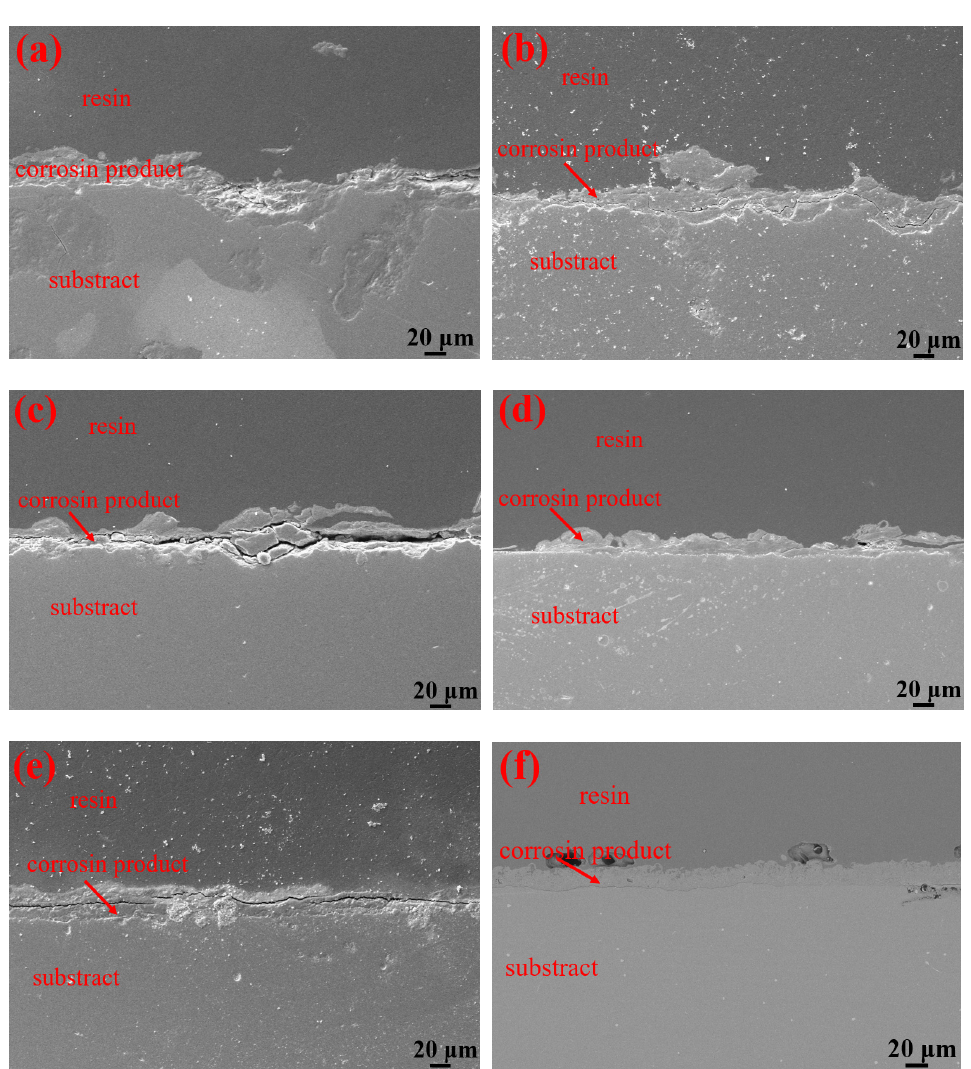
Figure 6. SEM cross-section images of corrosion products of S135 and G105 samples at different temperatures: ( a ) S135, room temperature; ( b ) G105, room temperature; ( c ) S135, 100 °C; ( d ) G105, 100 °C; ( e ) S135, 180 °C; ( f ) G105, 180 °C.